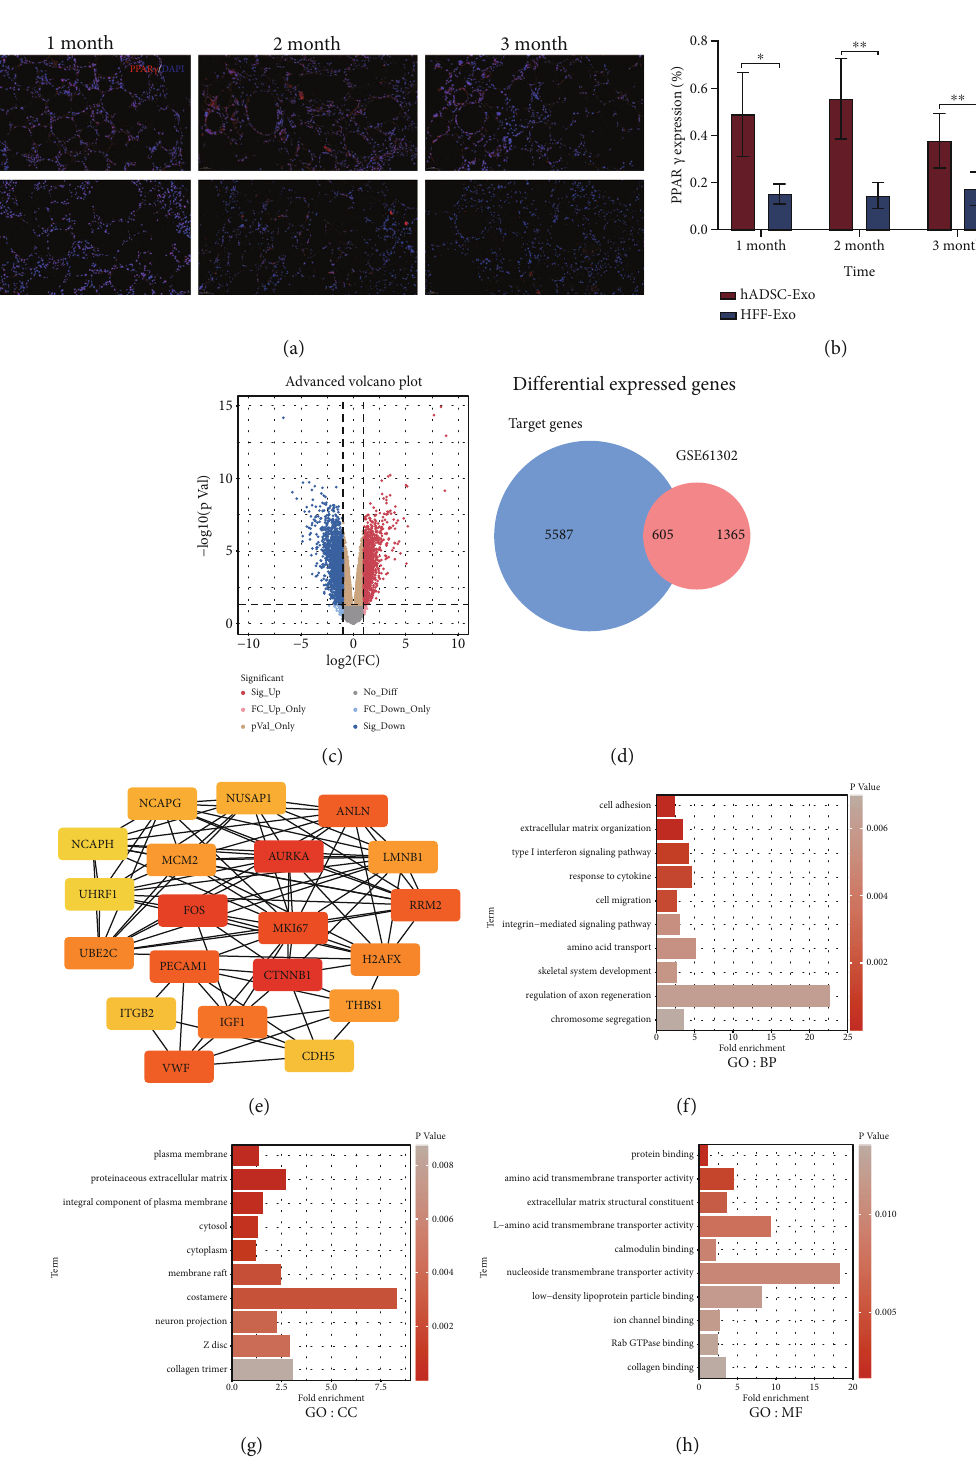
Figure 5: Comprehensive functional analysis of the key DEGs for lipogenesis targeted by hADSC-Exo. (a) The immuno fl uorescence staining revealed that hADSC-Exo group had evidently signi fi cant PPAR γ expression compared to the HFF-Exo group. (b) The positive percentage of PPAR γ expression in the fat grafts at 1, 2, and 3 months were calculated. (c) Volcano plot of the GSE61302 microarray dataset. (d) Venn diagram of key genes which may target by hADSC-Exo in the process of adipogenic di ff erentiation of ADSC. (e) The mapped network for the top 20 hub genes in protein – protein interaction network. (f) The category of “ biological process ” of the target DEGs. (g) The category of “ cellular component ” of the target DEGs. (h) The category of “ molecular function ” of the target DEGs ( ∗ p < 0 : 05 and ∗∗ p < 0 : 01